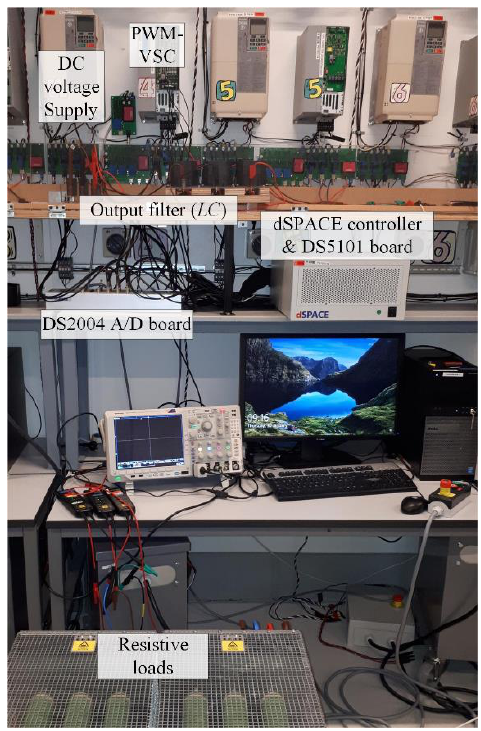
Figure 2. Experimental setup to implement the conventional model predictive control (MPC) and the proposed adaptive MPC on a three-phase inductor and capacitor filter (LC)-filtered voltage source inverter (VSI). Table 1. System parameters.